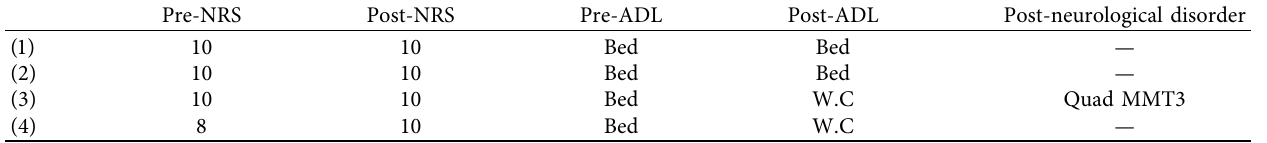
Table 1: Perioperative pain scale (NRS), ADL, and neurological complications.